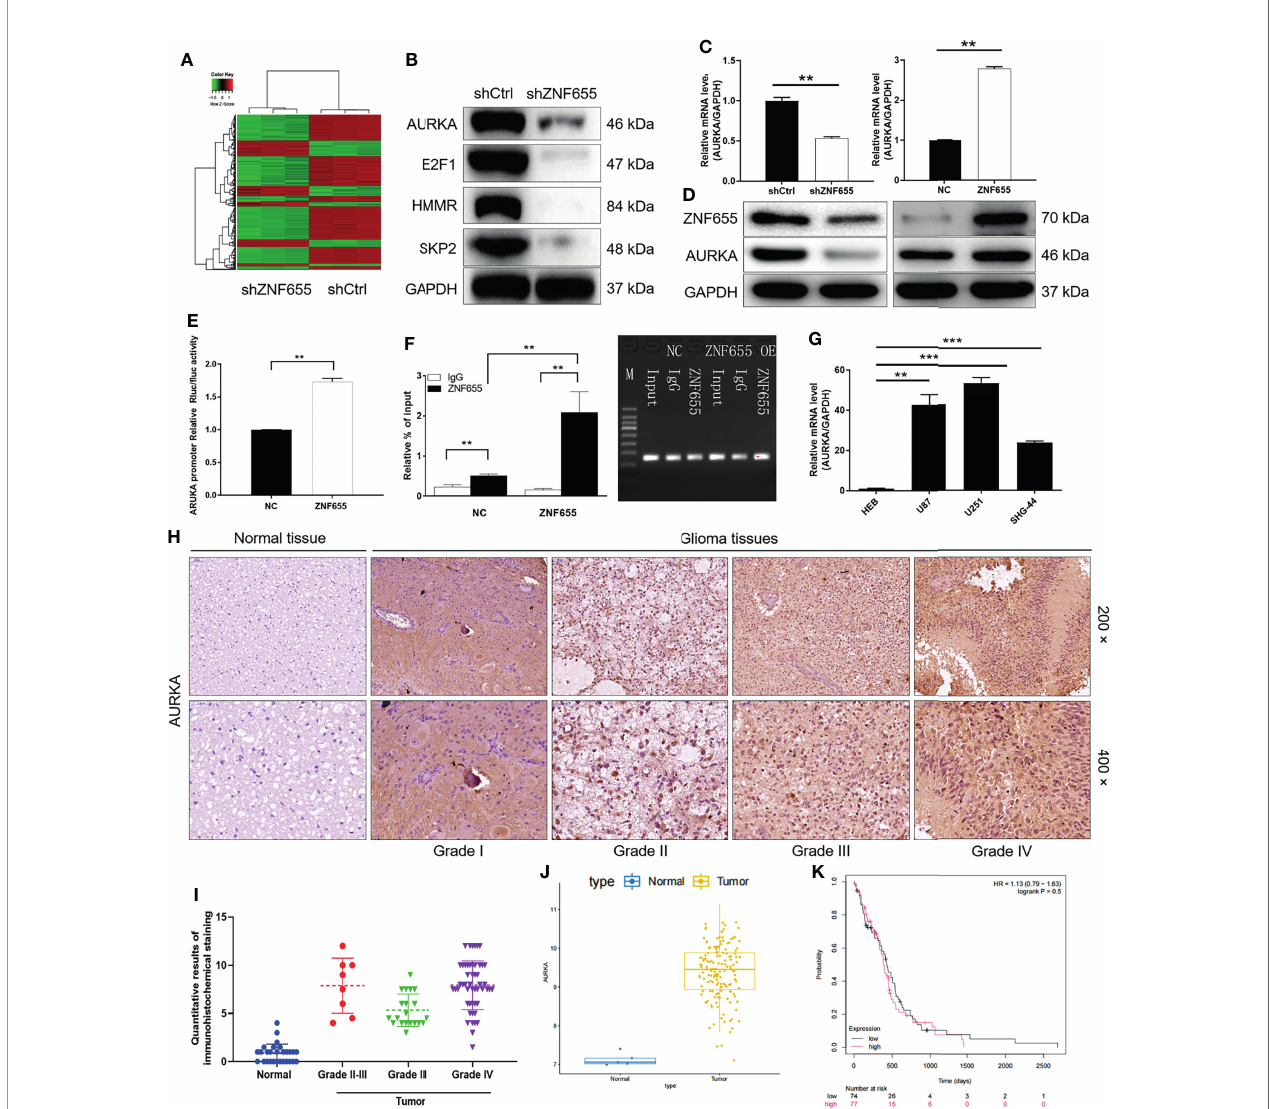
FIGURE 4 | ZNF655 directly binds to the AURKA promoter and regulates its activity. (A) Hierarchical clustering showed the DEGs of U251 cells after ZNF655 knockdown. (B) The expression of most signi fi cantly DEGs was identi fi ed by WB in U251 cells. (C, D) Effects of ZNF655 knockdown or overexpression on AURKA mRNA and protein expression. (E) We tested the effect of ZNF655 expression on AURKA promoter activity by constructing AURKA promotor dual luciferase reporter gene in U251 cells. (F) We performed ChIP-qPCR experiments to verify the mechanism of ZNF655 regulating AURKA. (G) The mRNA expression of AURKA was elevated in glioma cell lines (U87, U251, and SHG-44) and human brain normal glial cells HEB. (H, I) The expressions of AURKA in glioma tissue (n = 125; low grade, n = 49, high grade, n = 76) and normal tissue (n = 31) were analyzed through IHC staining (×200 magni fi cation and ×400 magni fi cation), and quantitative results of AURKA in gliomas were shown. (J, K) Based on the TCGA database, the expression levels of AURKA in glioblastoma and its correlation with survival were analyzed. The data were expressed as mean ± SD (n ≥ 3), **p < 0.01, ***p <